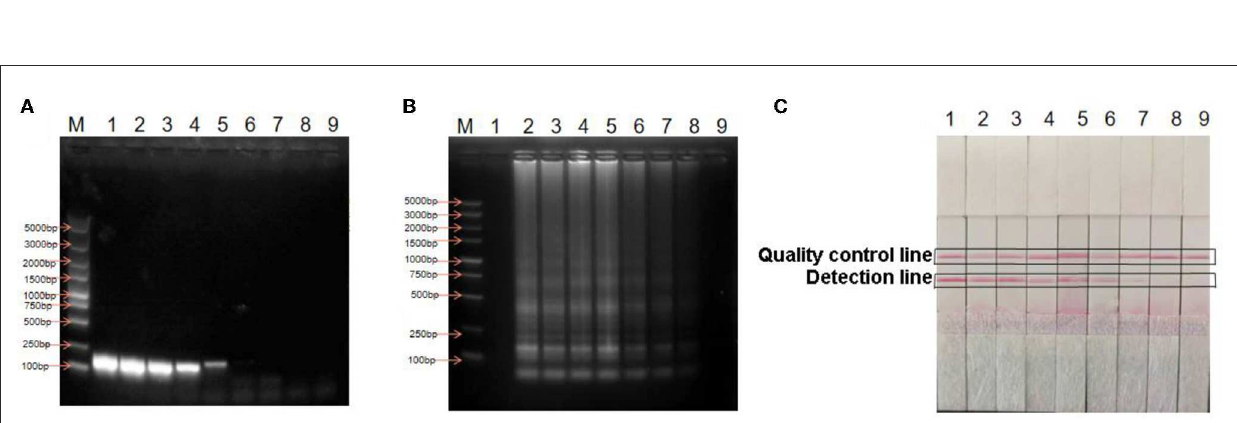
FIGURE4 Detection of sensitivity. (A) Sensitivity of PCR; (B) Sensitivity of LAMP agarose gel electrophoresis; (C) Sensitivity of LAMP-LFD; M: DNA Marker DL5000; lane 1: Negative control; lane 2: 10 8 copies/ µ L; lane 3: 10 7 copies/ µ L; lane 4: 10 6 copies/ µ L; lane 5: 10 5 copies/ µ L; lane 6: 10 4 copies/ µ L; lane 7: 10 3 copies/ µ L; lane 8: 10 2 copies/ µ L; lane 9: 10 1 copies/ µ